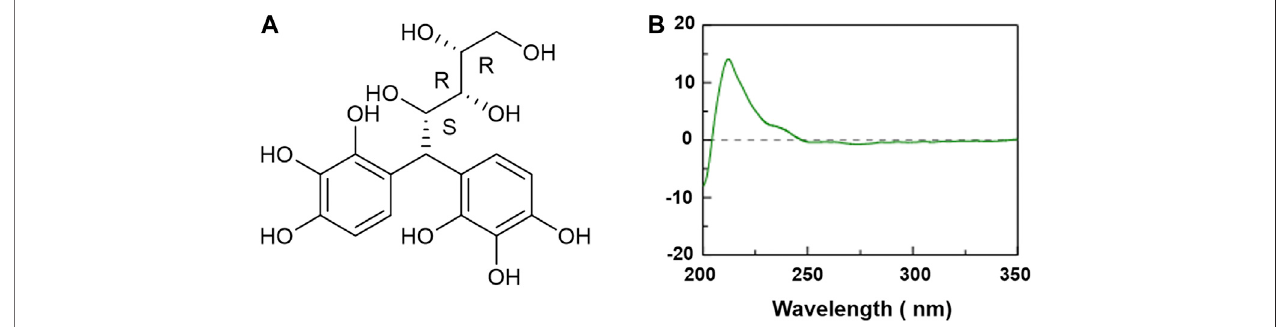
FIGURE1| ChemicalstructureandcirculardichroismspectraofXylose-pyrogallol(XP)inwater. (A) ChemicalstructureofXP. (B) CDspectraofXPinwaterat0.5 mM.